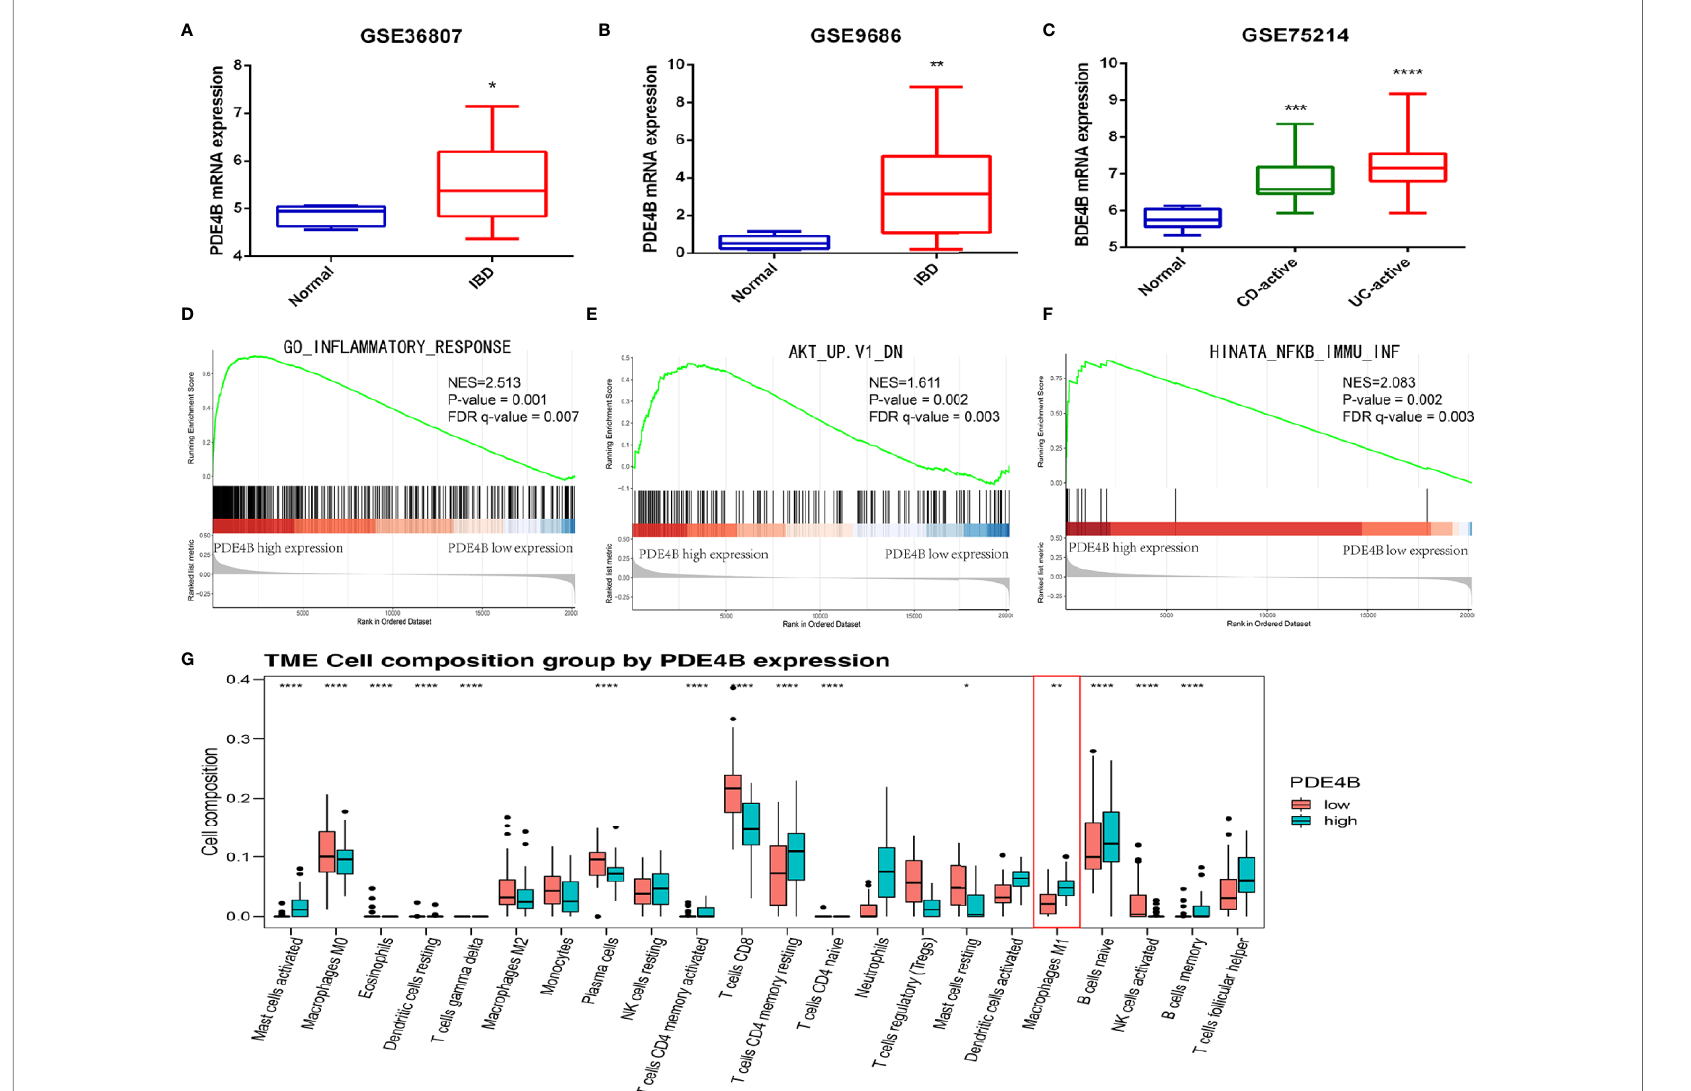
FIGURE 6 | The biological function of PDE4B in in fl ammatory bowel diseases by bioinformatics analysis. (A – C) The box plot showed the level of PDE4B between normal samples and IBD samples in GSE36807 cohort (A) , GSE9686 cohort (B) , and GSE75214 cohort (C) . (D – F) GSEA showed that PDE4B played a positive role in “ in fl ammatory response ” (D) , as well as the “ AKT ” (E) and “ NF- k B ” (F) signaling pathways. (G) The box plot showed the correction of PDE4B level, and the in fi ltration of 22 types of immune cells was determined by the CIBERSORT R package. Data are shown as the mean ± SD. *P < 0.05; **P 0.01; ***P < 0.001; ****P <